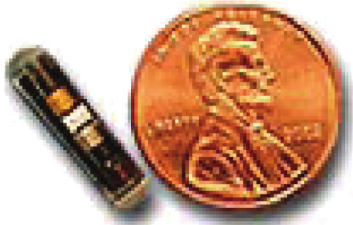
Figure 5: An image shows a miniature size of in vivo blood glu- cose sensor that is being developed [15]. It is currently proven by FDA that in vivo blood glucose sensors are only safe and reliable in a short period of time (e.g., three days). Thus after the period, they are required to be replaced by a new one regularly to keep their accuracy.